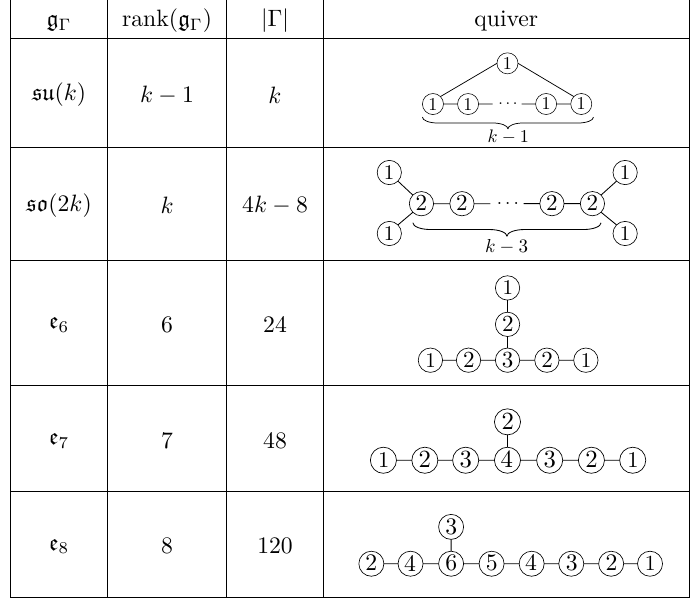
Table 1 . For each ADE subgroup Γ of SU(2) , we give the associated Lie algebra g Γ , its rank, the order Γ of the group, and the quiver that describes the worldvolume theory of D3-branes probing C 2 / Γ . The number associated to each node is denoted n i in the text. A node with label n i corresponds to a gauge group U( N n i )